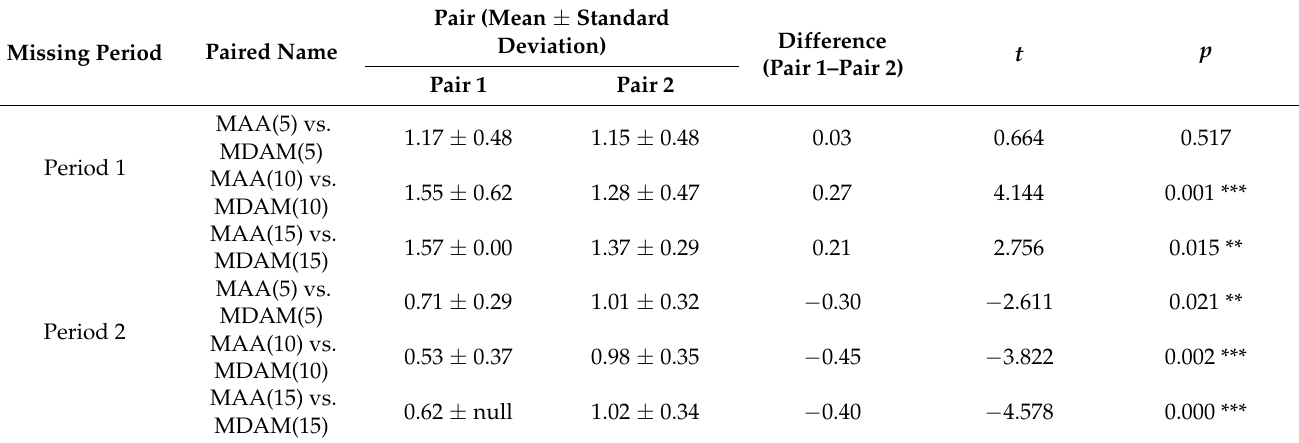
Table 8. Results of paired t -test analysis of missing data in both MAA and MDAM methods